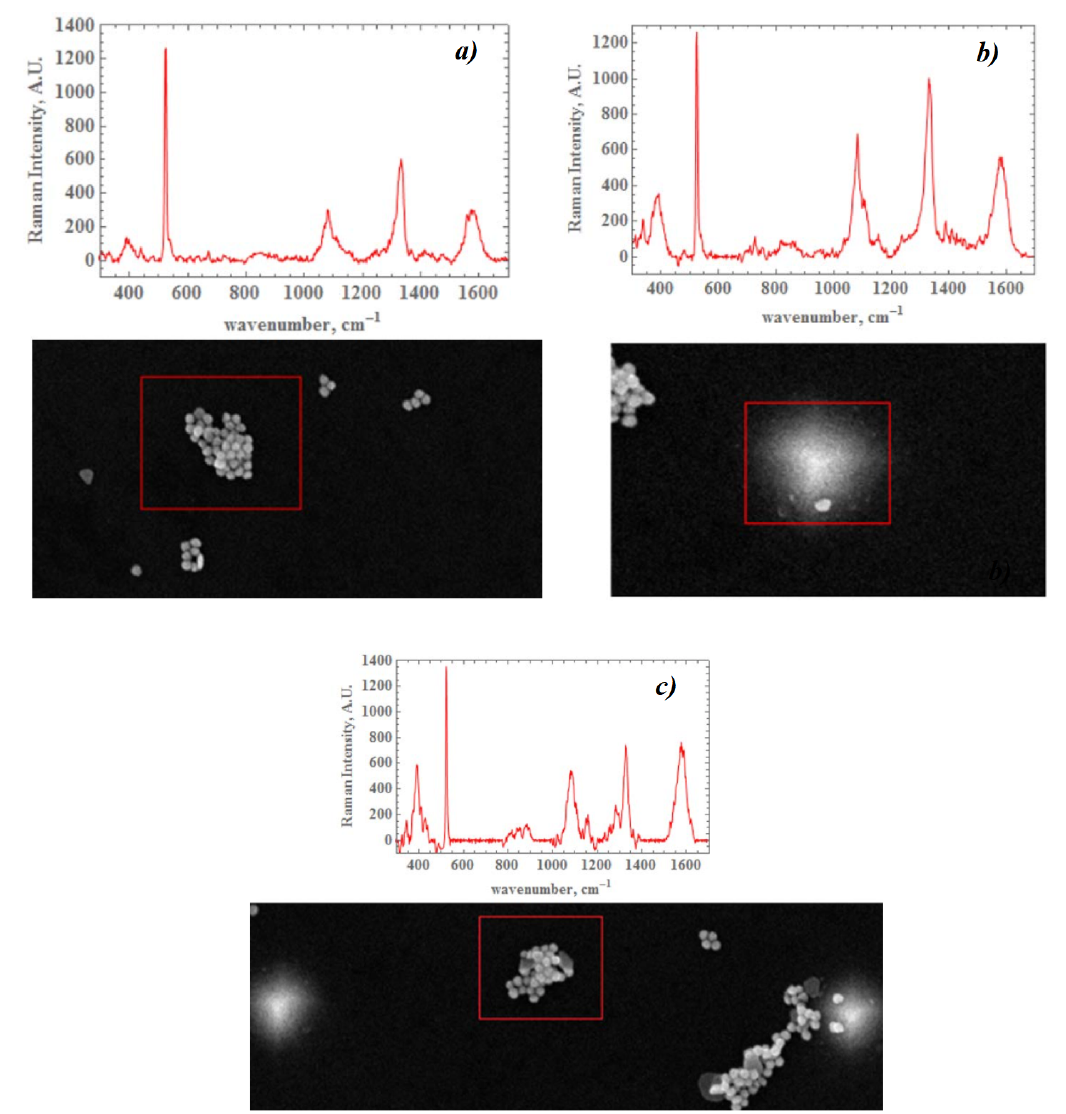
Figure 31. Raman intensity (SERS) obtained with AuNP-DTNB conjugates placed on different areas of cone-shaped metasurface; the areas where the Raman signal is collected are shown by red squares; apexes of the cones look like blurred specks, AuNP-DTNB conjugates look like bright spots. SEM images and SERS spectra recorded: ( a ) outside of grating, ( b ) on the pyramid side and ( c ) between pyramids. Reprinted with permission from [18], the Optical Society